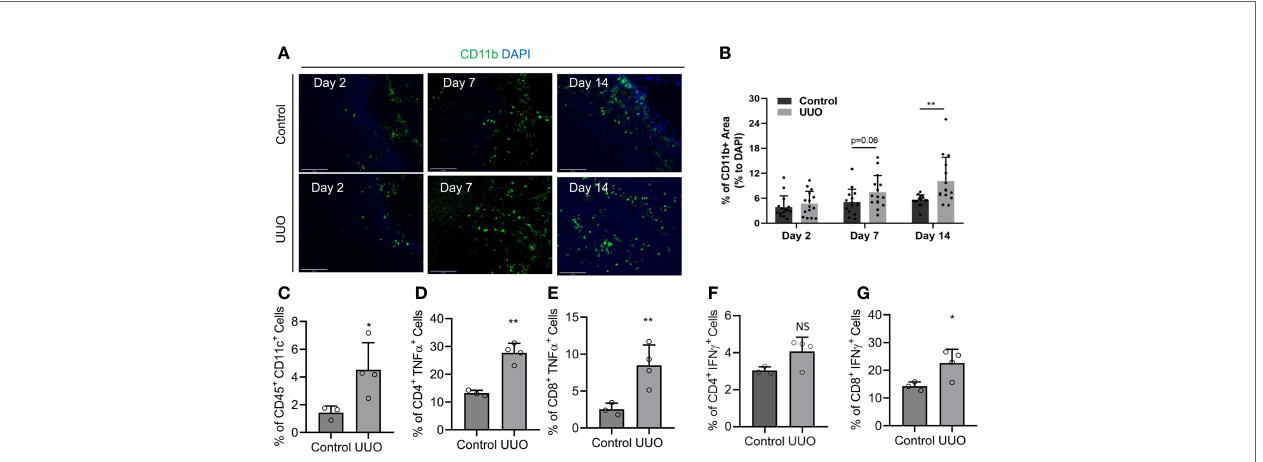
FIGURE 2 | In fi ltration of antigen-presenting cells and activation of lymphocytes in the UUO KLN. (A, B) (A) Fluorescence micrographs of CD11b + antigen-presenting cells (green) and (B) semiquantitative analysis of CD11b + staining normalized to DAPI + area (blue) indicate that the density of CD11b + antigen-presenting cells increases in the UUO KLN over time, and it is signi fi cantly higher than the contralateral (control) KLN at Day 14. (C – G) Flow cytometric analysis of KLNs at Day 14 indicate signi fi cantly higher percentages of (C) CD45 + CD11c + dendritic cells, (D) CD4 + TNF a + T cells, (E) CD8+TNF a + T cells, (F) CD8 + IFN g + T cells, and higher percentage of (G) CD4 + IFN g + T cells in the UUO KLN than the contralateral (control) KLN at Day 14 (n=3-4 mice). Data represented by means ± SEM. *p < 0.05, **p < 0.01. NS, not signi fi